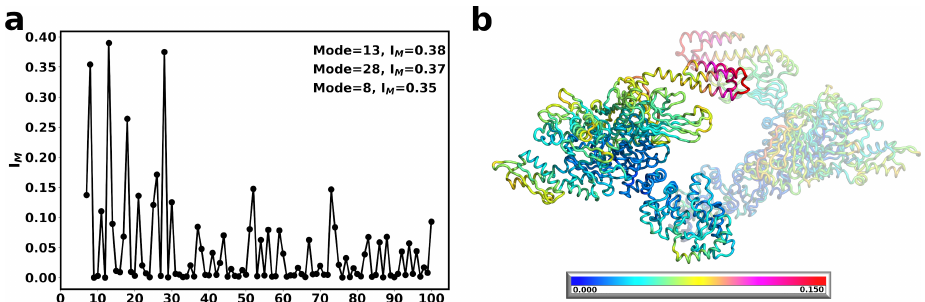
Figure 6. Normal modes of symmetric DnaK bound Hsp90 Ec ( a ) Structural overlap of the two DnaK bound Hsp90 Ec model with ADP bound Hsp90 Ec to identify the dominant modes that contribute to the biological movement. The closed circles represent the overlap for individual modes. Lines are drawn for clarity. Nonzero modes with the highest structural overlap are considered.( b ) The sum of the individual amino acid fluctuations in both modes 13, 28, and 8 are represented on the structure of Hsp90 Ec . Blue represents static residues while red highlights highly mobile